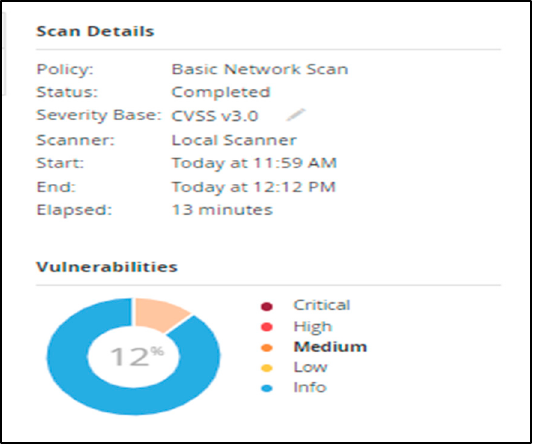
Figure 9. Results of scanning—medium vulnerabilities.